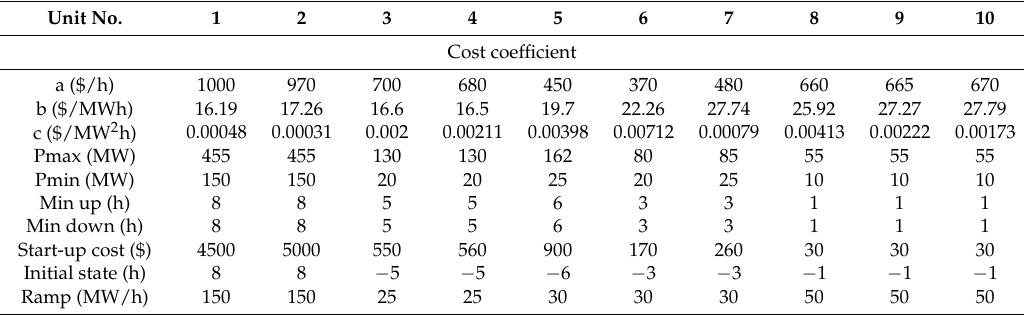
Table 1. Generator data for the 10-unit system [27]. Unit No.